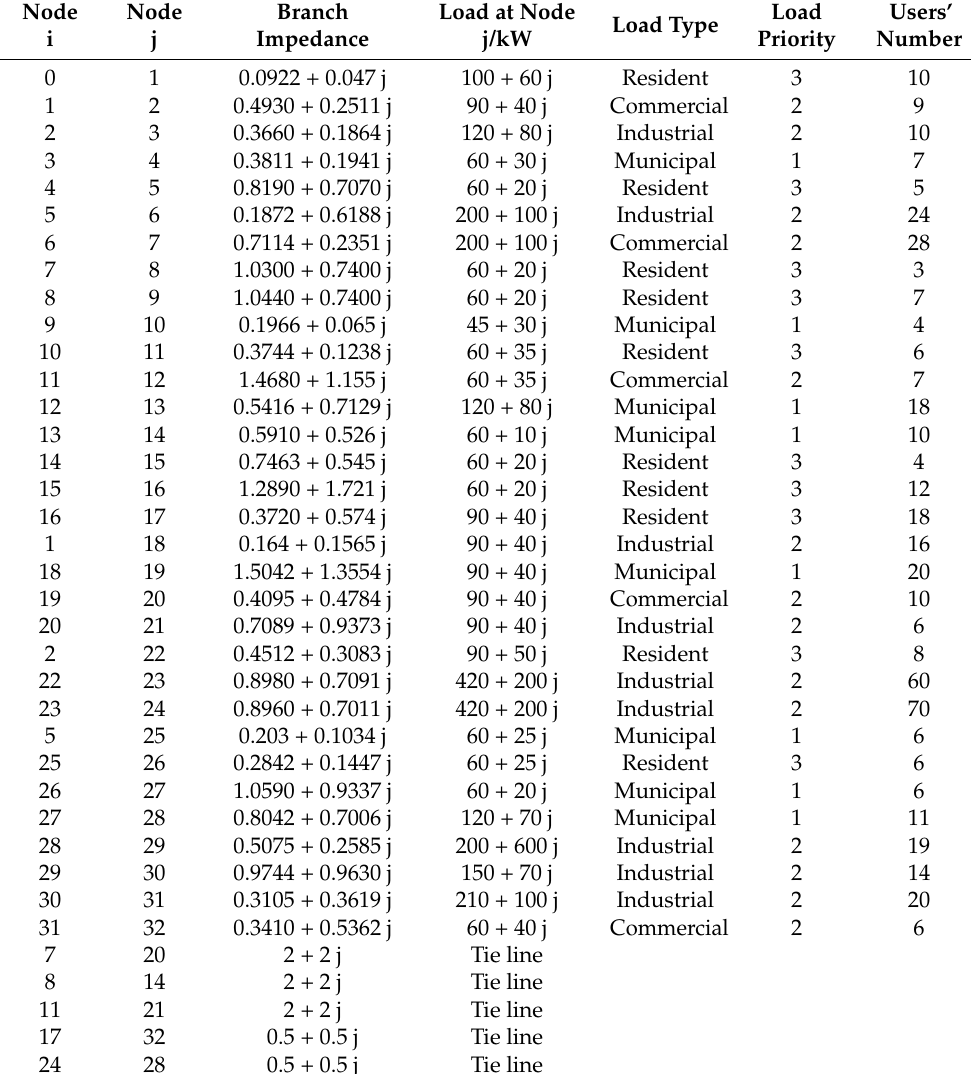
Table A1. IEEE 33 System